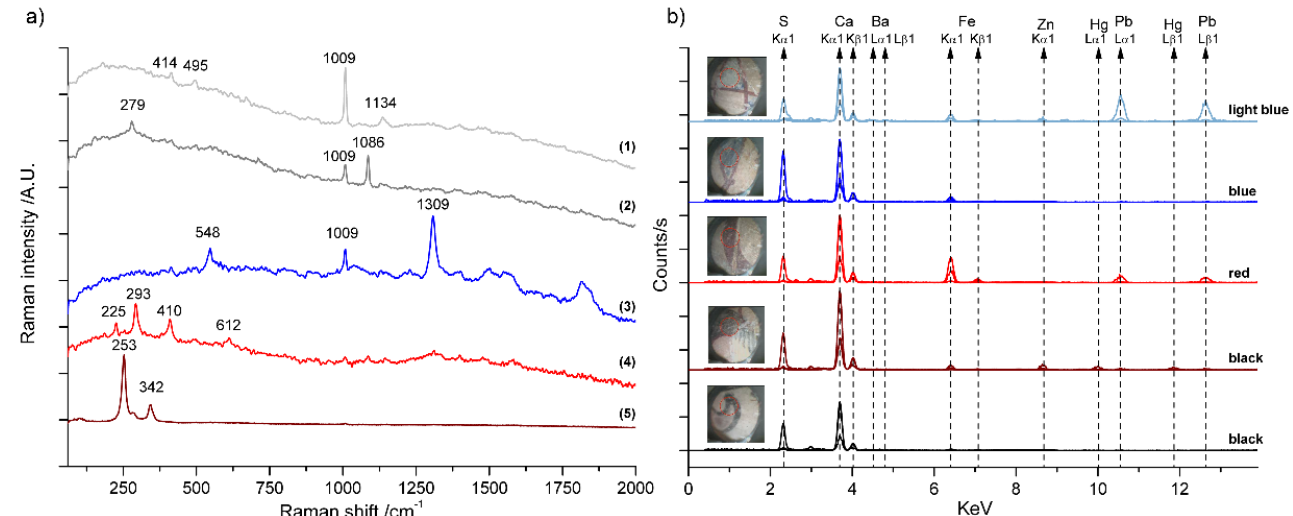
Figure 3. Representative spectra registered during the in situ study. ( a ) Raman spectra of different compounds identified in situ: (1) gypsum; (2) calcite with gypsum; (3) lapis lazuli; (4) hematite; (5) cinnabar. ( b ) XRF spectra (with filters for light, low and high ranges) of different motifs labeled with the macro-observed color. Inset images correspond to the analyzed area (marked with a red circle).